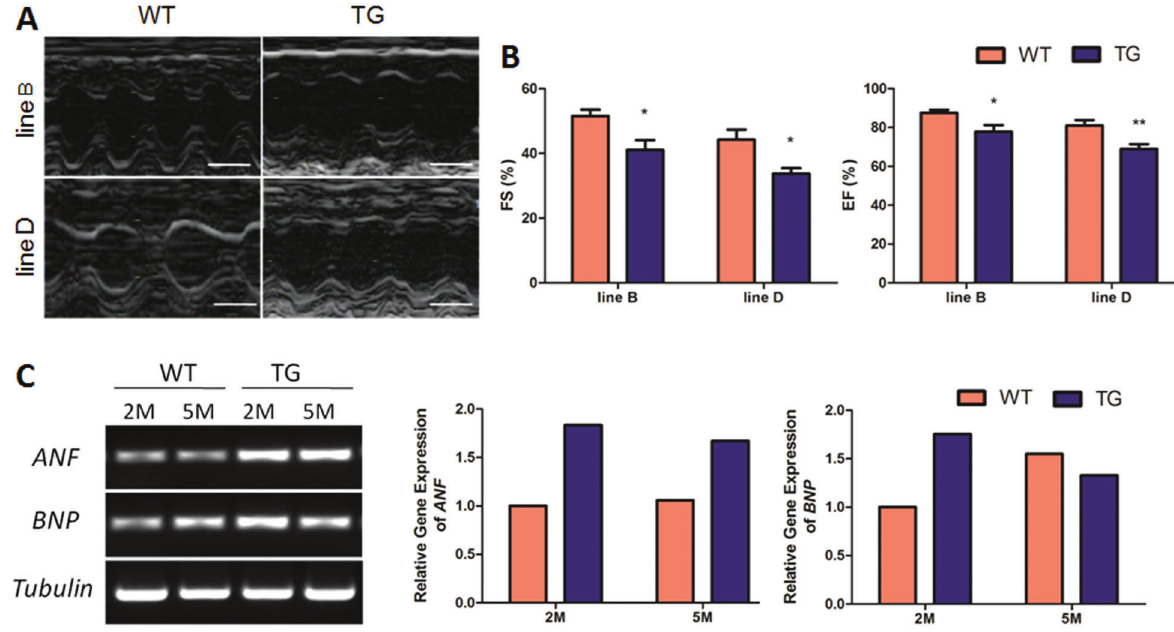
Figure 4. MyD88 transgenic (TG) mice showed reduced cardiac contractility and elevated heart failure marker expression. A , Representative M-mode echocardiographic views of wild-type (WT) and TG hearts at 5 months (M) of age. Scale bar, 20 m m. B , Statistical analysis of echocardiographic parameters of WT and TG mice (n=5 – 11). FS%: fractional shortening, FS% = (LVEDD (cid:3) LVESD)/LVEDD (cid:1) 100; EF%: ejection fraction, EF% = (LVEDD 3 (cid:3) LVESD 3 )/LVEDD 3 (cid:1) 100. *P o 0.05, **P o 0.01 compared to WT (two- tailed Student ’ s t -test). C , Measurement of atrial natriuretic factor ( ANF ) and brain natriuretic peptide ( BNP ) mRNA levels in WTand TG hearts at 2 and 5 months of